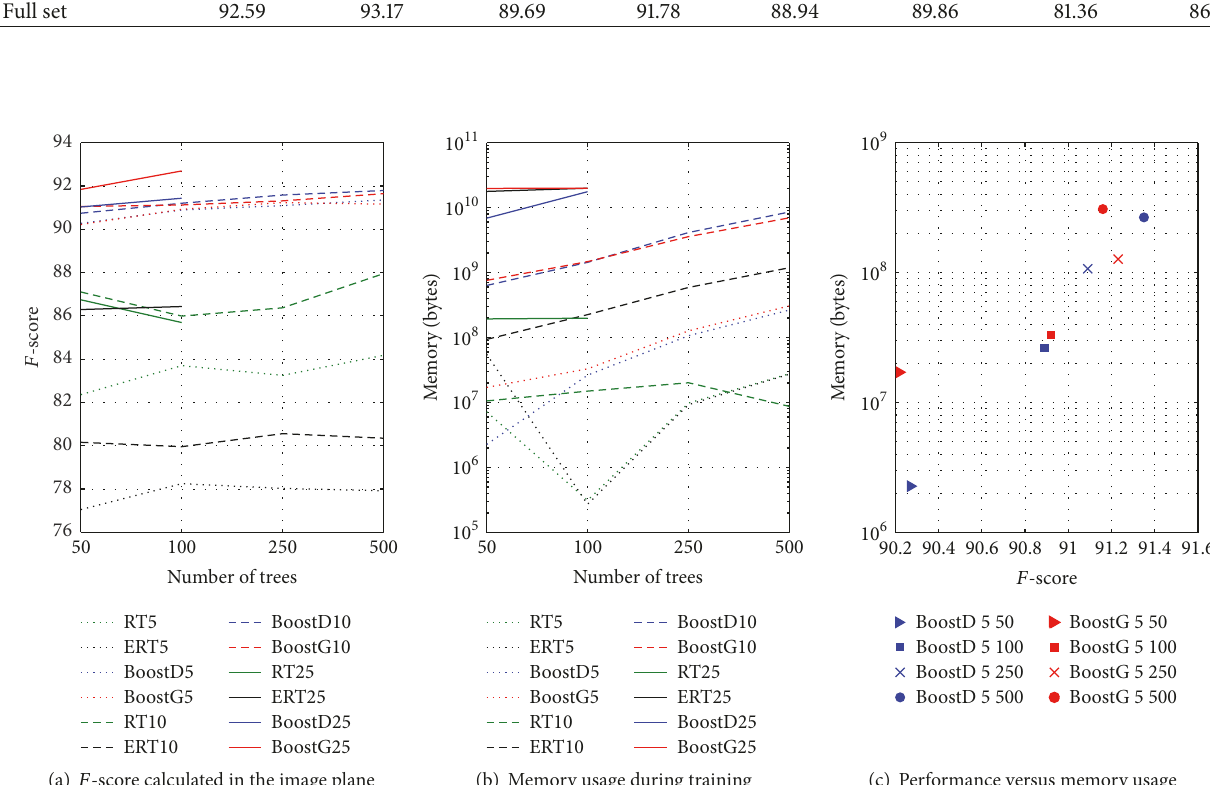
Figure 16: Selection of the best